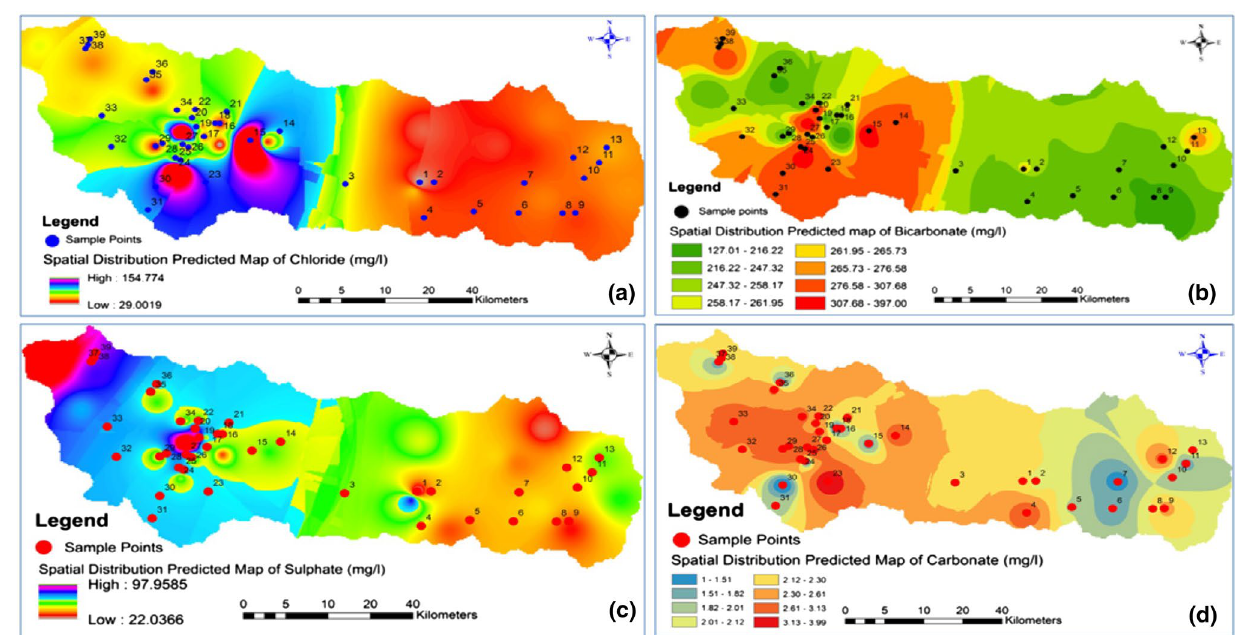
Fig. 4 Spatial distribution map of the major